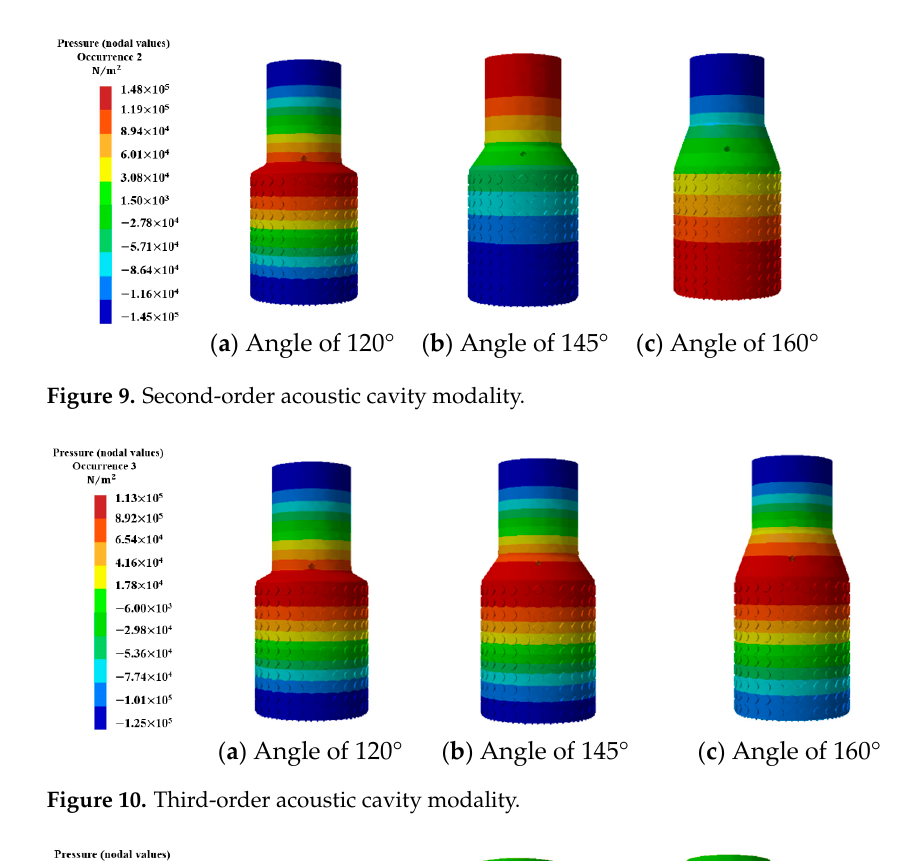
Figure 8. First-order acoustic cavity modality.